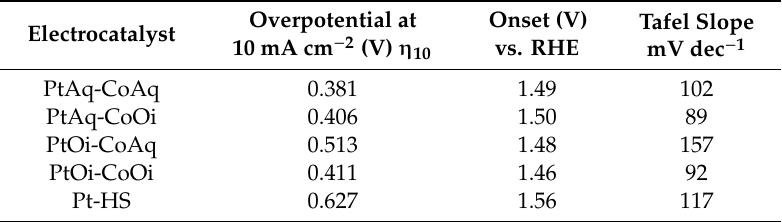
Table 2. The overpotential at 10 mA cm −2 , onset of oxygen evolution and Tafel slopes for the electrocatalysts.